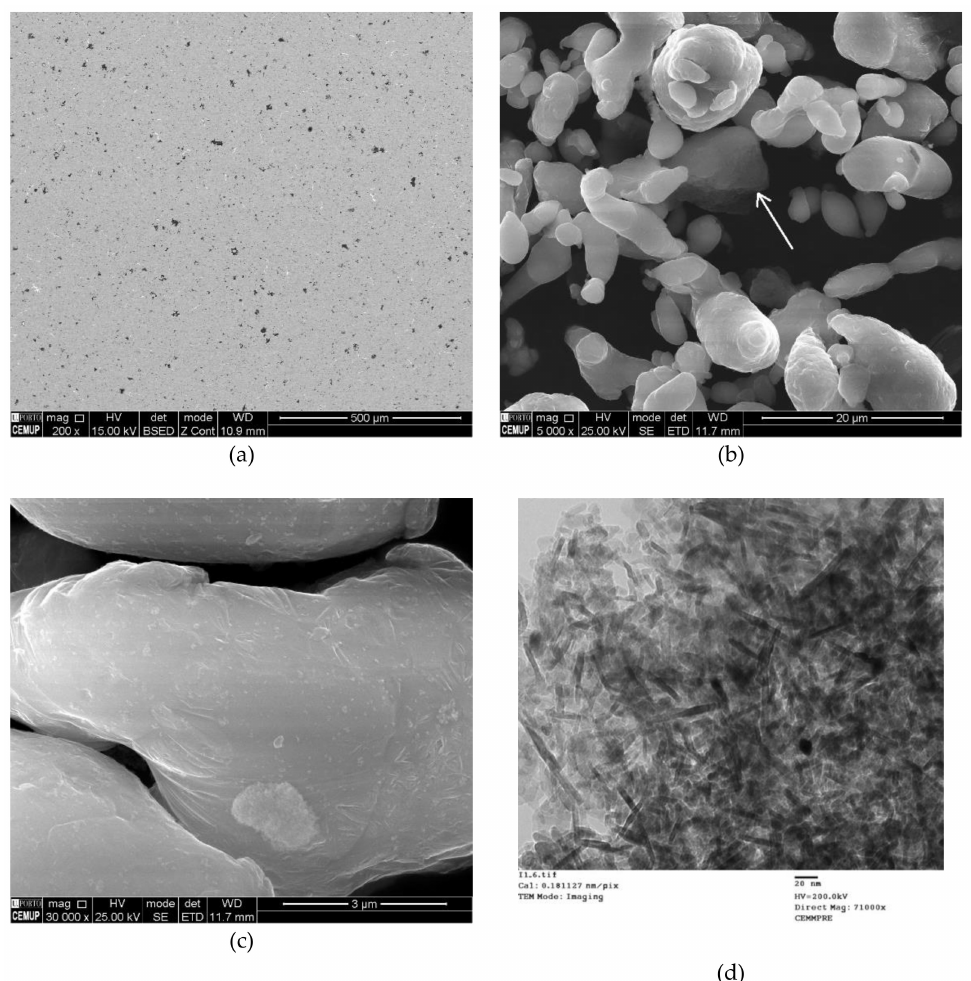
Figure 8. SEM/SE images showing ( a ) the as polished surface of the sintered Al-1 vol. % Nanoalumina specimen; ( b ) the presence of large agglomerates among Al particles (white arrow); and ( c ) fine distributions on particle surfaces; and ( d ) TEM image from nanoalumina agglomerate after ultrasonication for 15